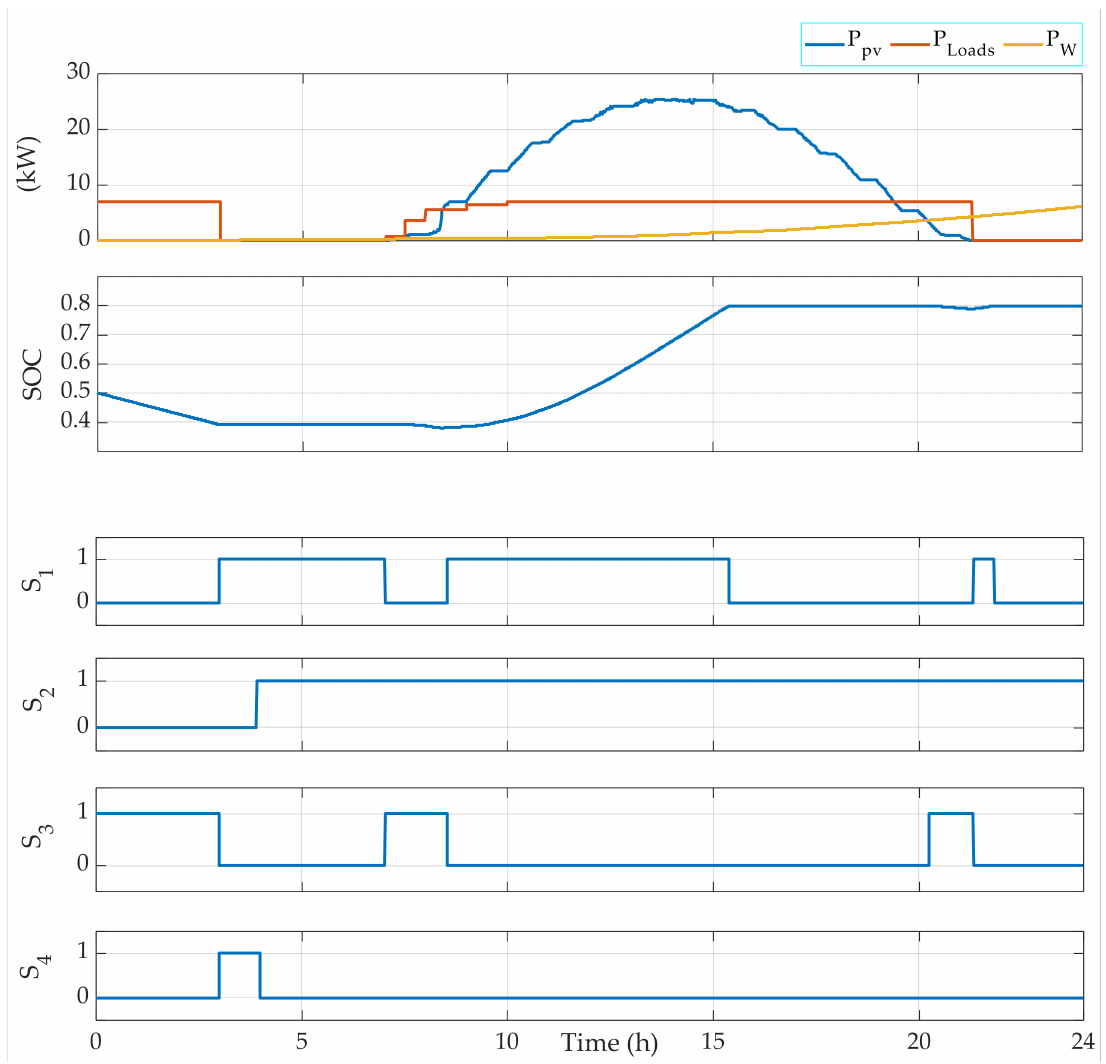
Figure 4. EMS results obtained for a typical day in July with an initial SOC = 50%.